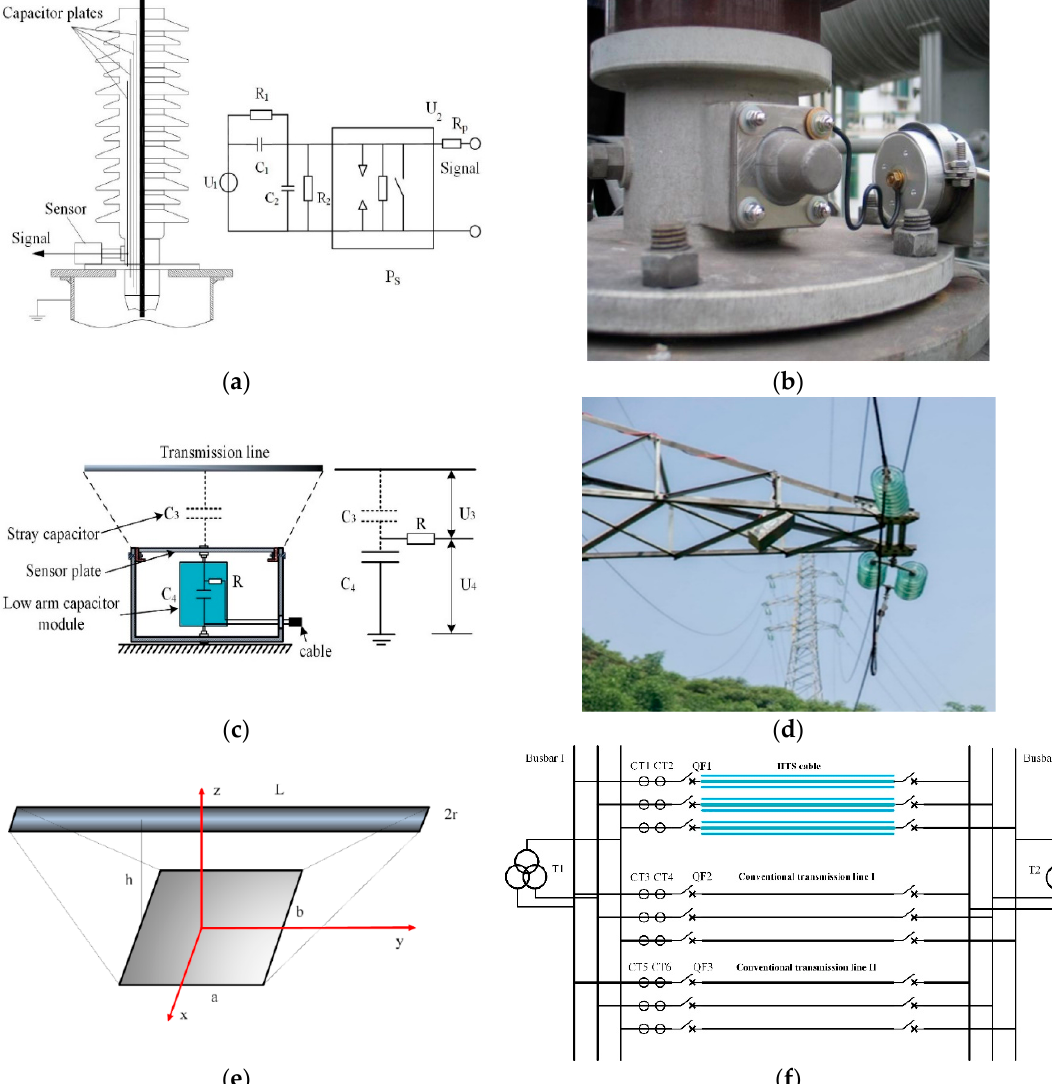
Figure 3. ( a ) schematic diagram of the transformer bushing sensor; ( b ) Installation scheme of the transformer bushing sensor; ( c ) schematic diagram of the transmission line sensor; ( d ) Installation scheme of the transmission line sensor ( e ) Wiring diagram of monitoring system ( f ) Typical wiring diagram of power gird with high-temperature superconducting (HTS) cables.